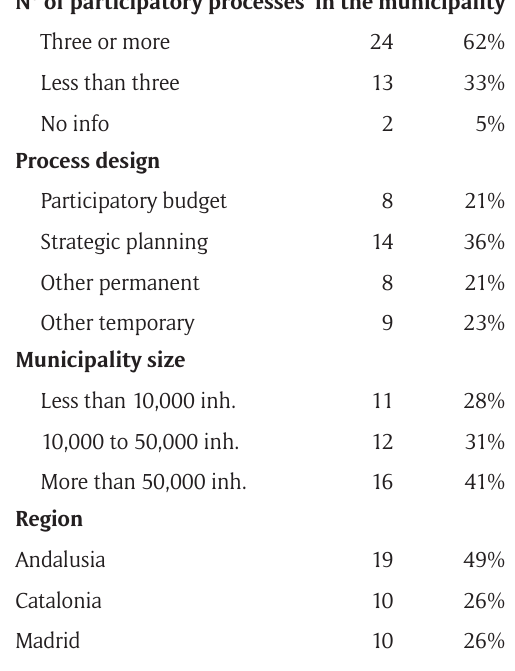
Table 1: Final sample